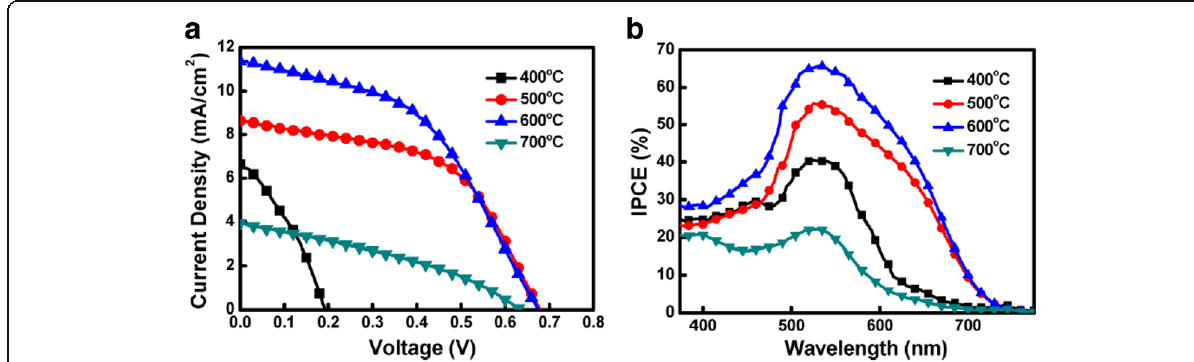
Fig. 7 The a current density – voltage ( J – V ) and b incident monochromatic photon-to-current conversion efficiency (IPCE) curves of DSSCs using various Cu 2 O CE